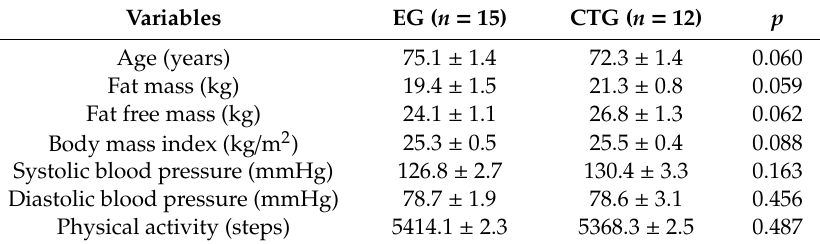
Table 1. Physical and physiological characteristics of subjects.